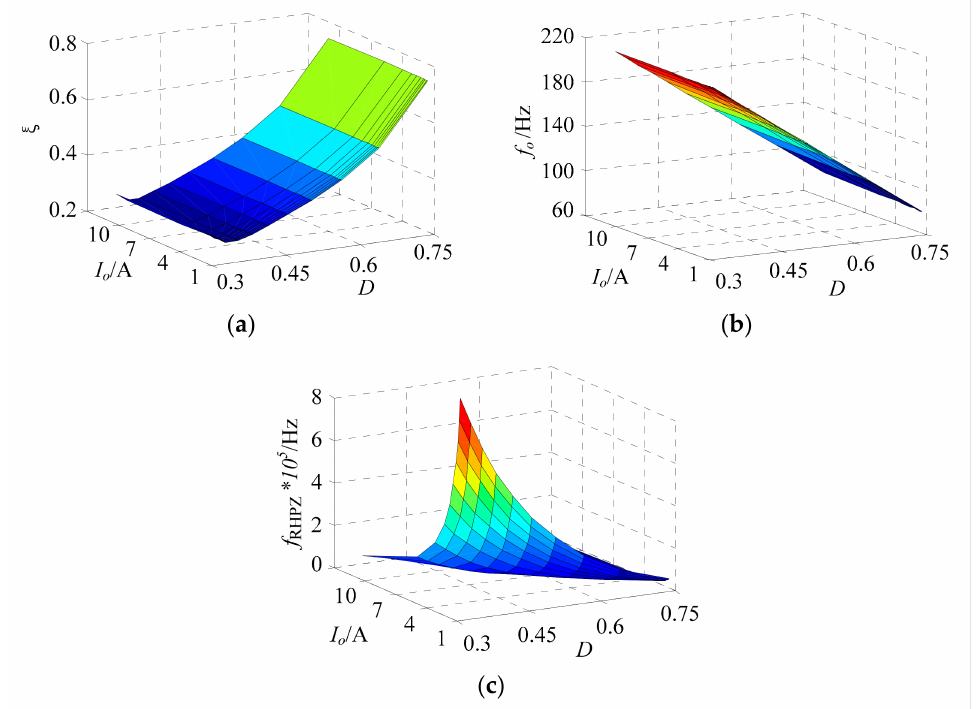
Figure 5. Damping, poles and zero positions versus duty cycle D and load I o . ( a ) ξ versus D and I o . ( b ) f o versus D and I o . ( c ) f RHPZ versus D and I o